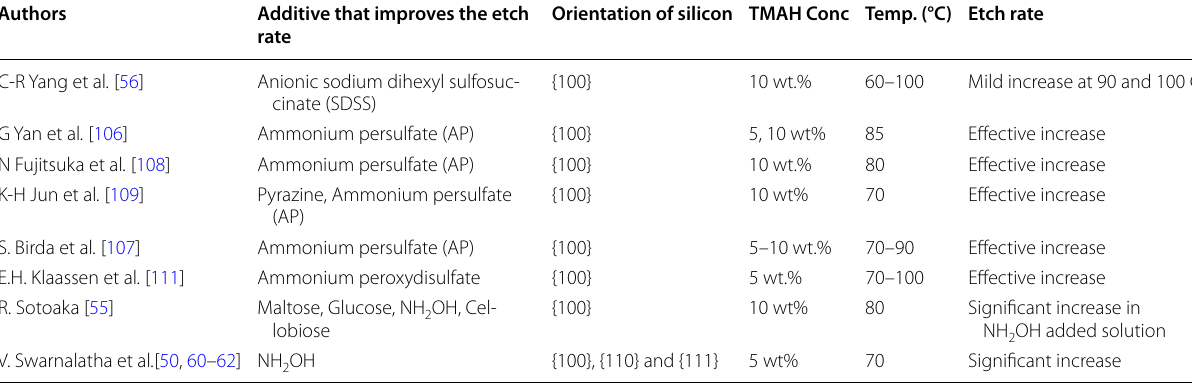
Table 2 The effect of various kinds of additives on the etch rate of silicon in TMAH